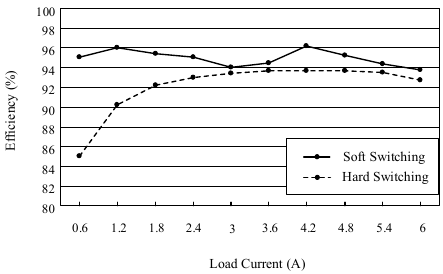
Figure 35. E ffi ciency vs. load Figure 35. Efficiency vs. load current.